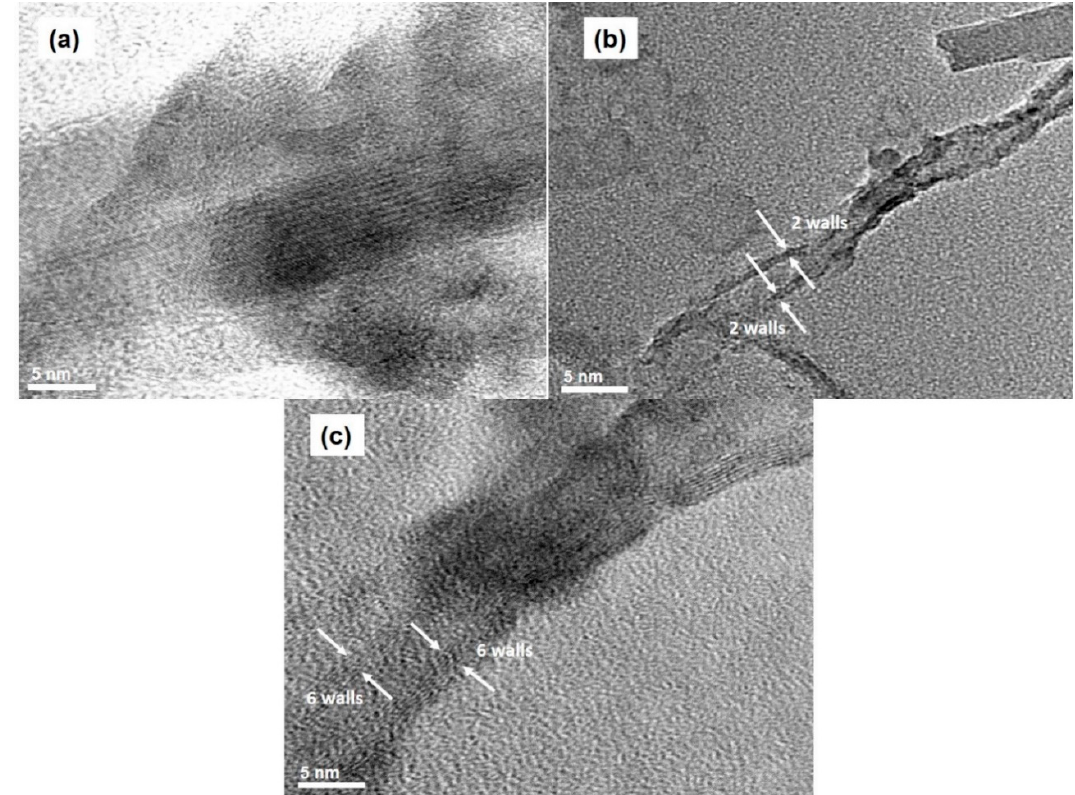
Figure 12. TEM images of synthesized CNTs at the temperature of 850 °C: ( a ) bundles of single-walled, ( b ) double-walled, and ( c ) multiwalled CNTs.